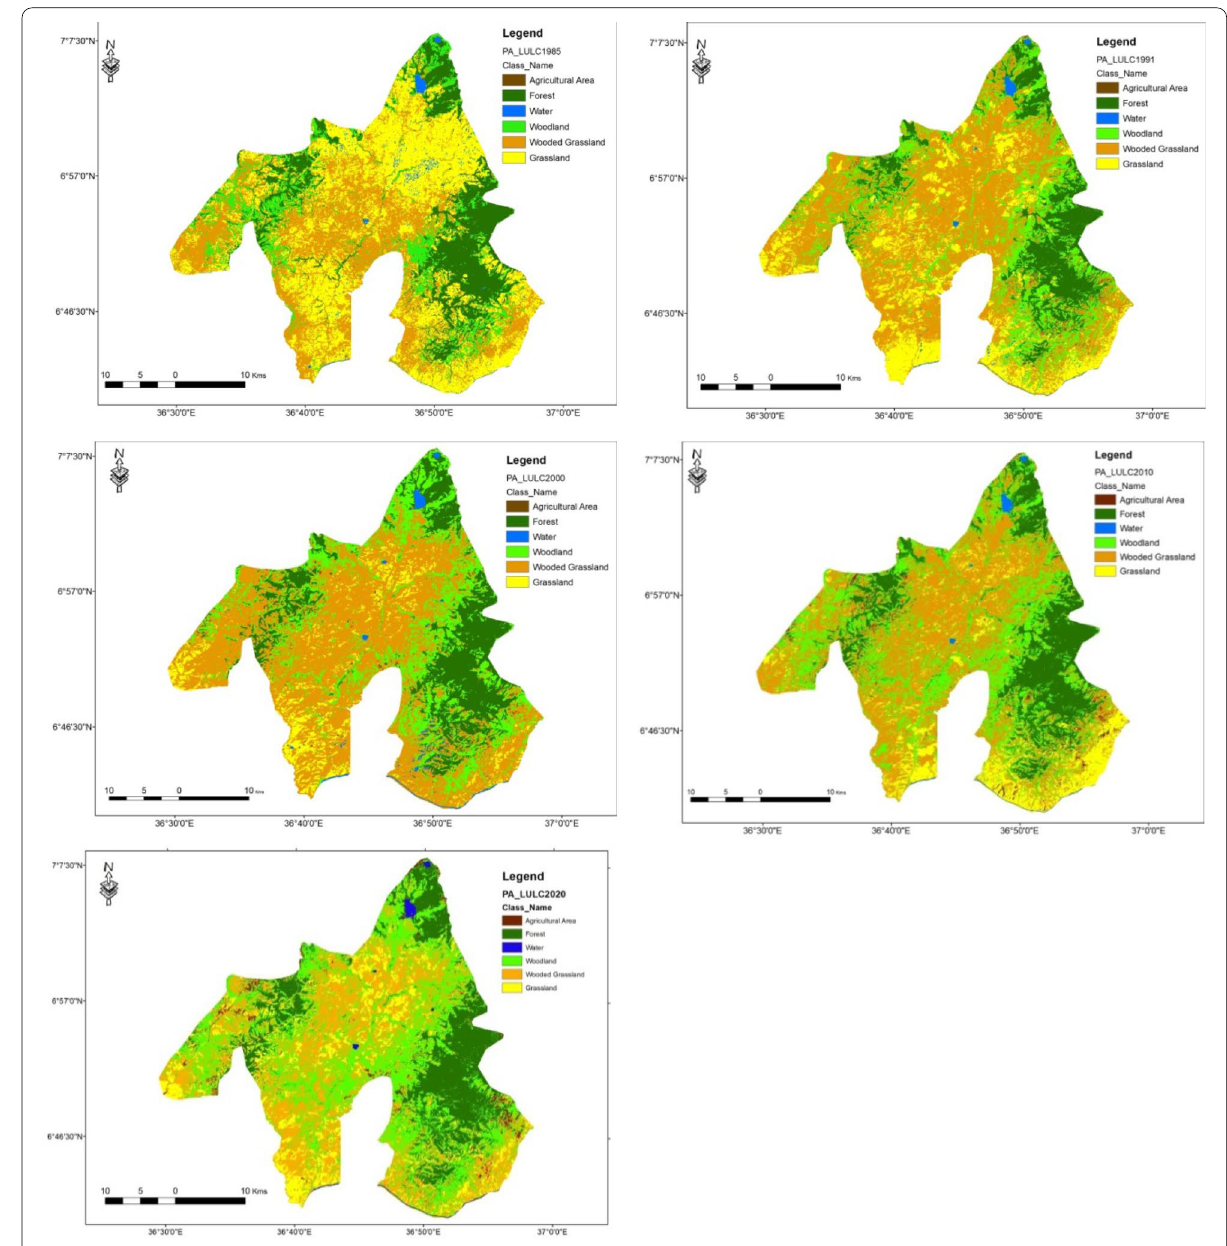
Fig. 2 Land use land cover classes within the park area, from top-left to bottom-right, in 1985, 1991, 2000, 2010 and